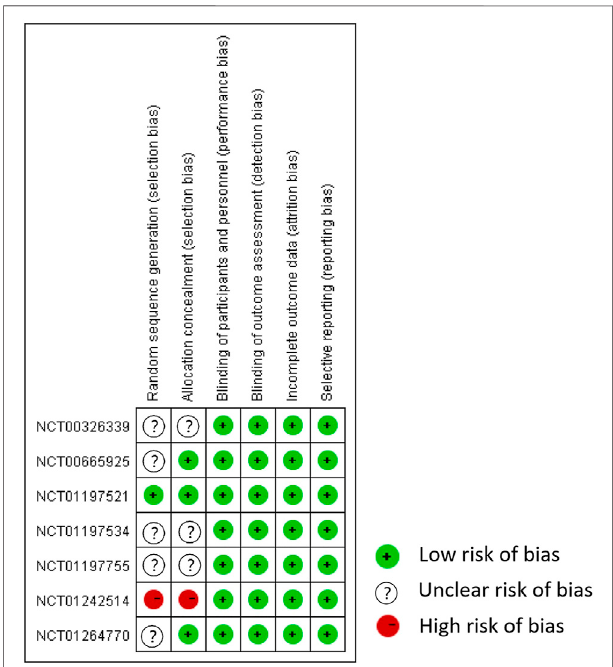
FIGURE 3 | Risk of bias summary. Adapted from Chen et al. (2021).